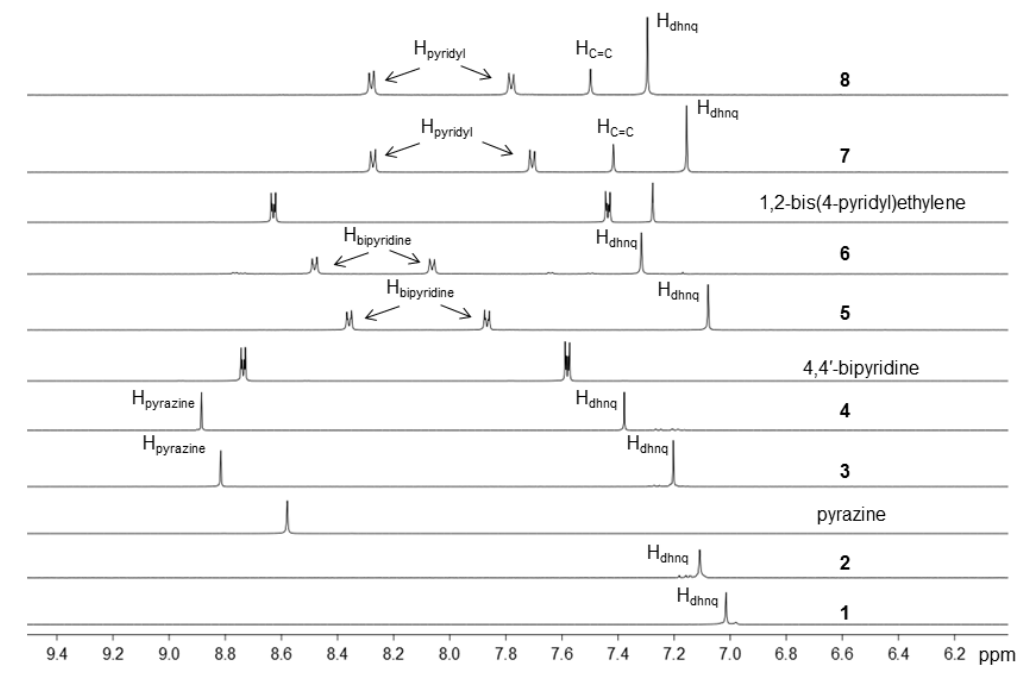
Figure 2. 1 H NMR spectra (aromatic region) of free pyrazine, 4,4′-bipyridine and 1,2-bis(4-pyridyl)ethylene, as well as the dinuclear complexes 1 – 2 and the metalla-rectangles 3 – 8 in CD Cl (25 2 2